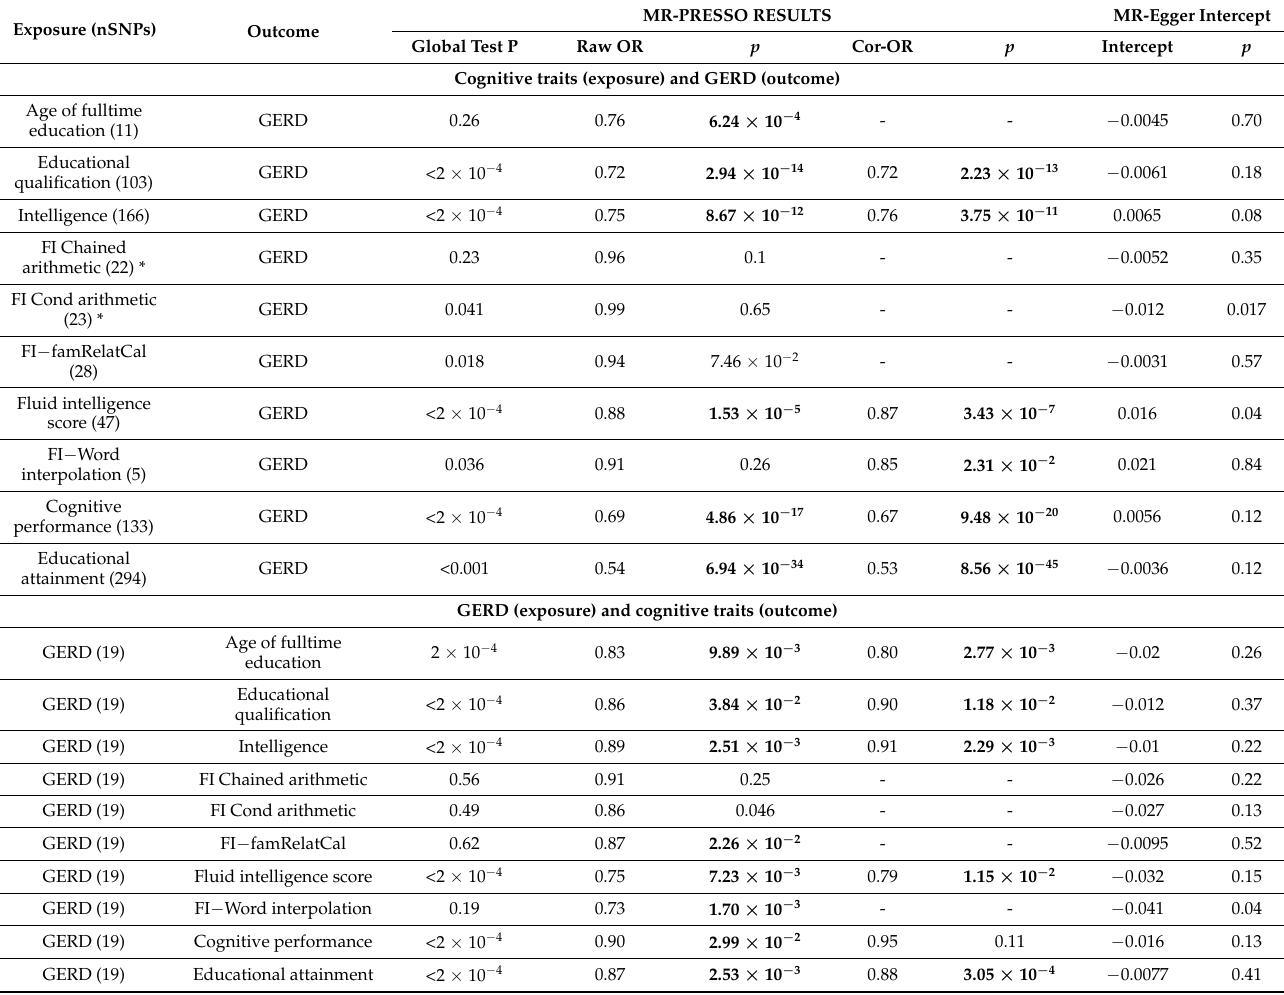
Table 5. Results of bidirectional MR-PRESSO analysis between GERD and cognitive